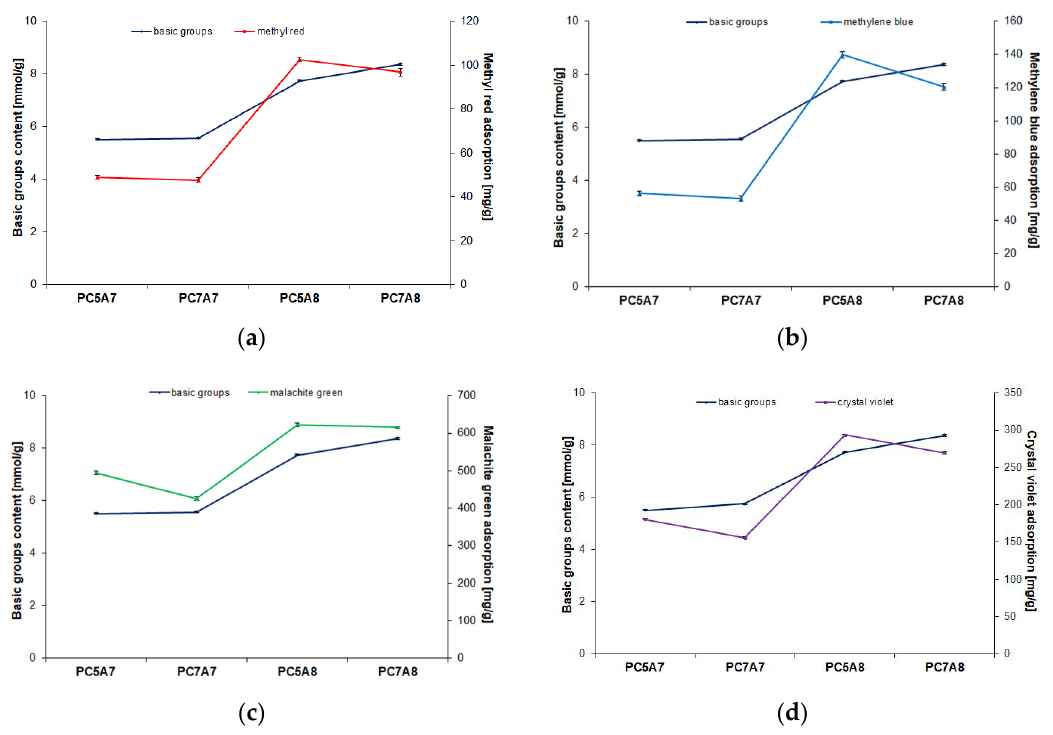
Figure 14. Dependence of dyes adsorption capacity on basic groups content: ( a ) methyl red, ( b ) methylene blue, ( c ) malachite green, ( d ) crystal violet.